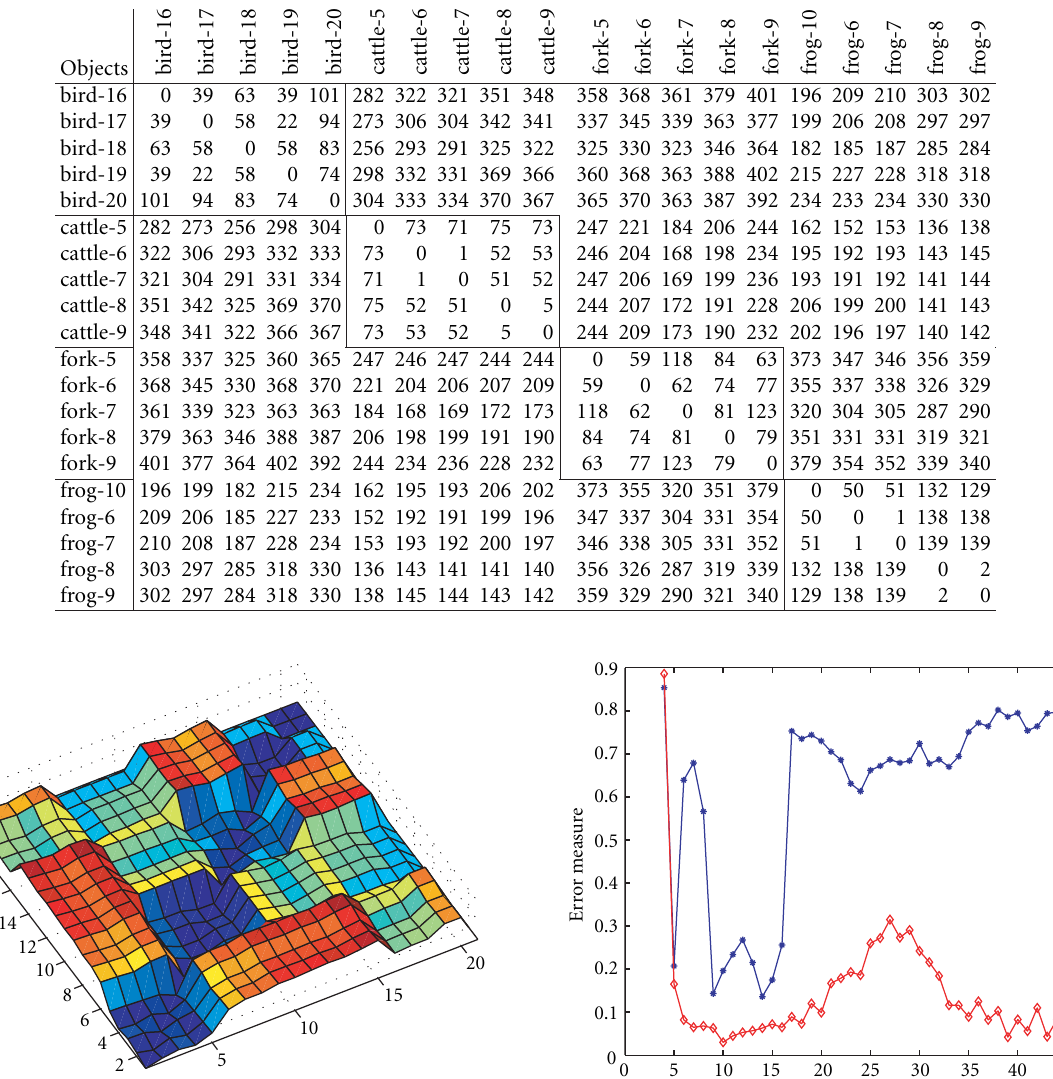
Table 2: Similarity scores for the contours in Figure 7. These scores are multiplied by 10 3 .